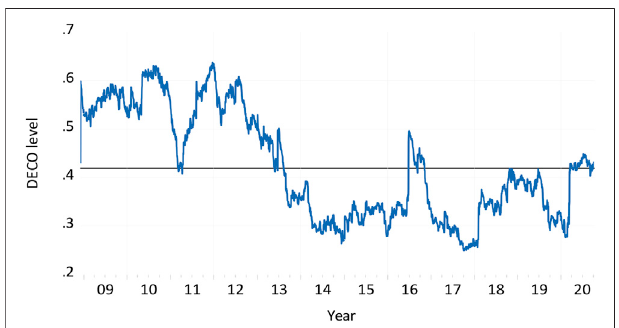
FIGURE1| Thereturnequicorrelation.Notes:This fi gureshowsthetime evolution of the DECO return equicorrelation among the indices under study (estimated based on the model described in Section 2.2 .) for the period December 1, 2008 — October 8,